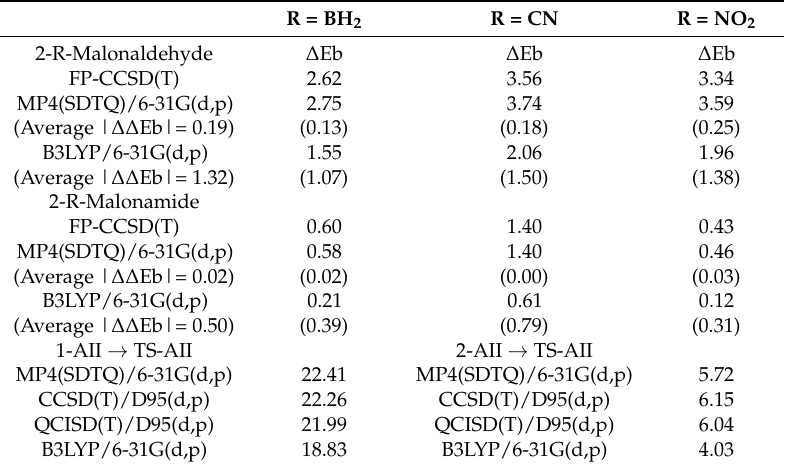
Table 2. Performance of MP4(SDTQ)/6-31G(d,p)//B3LYP/6-31G(d,p) in estimating the proton transfer barrier of six malonaldehyde derivatives. | ∆∆ Eb| refers to the absolute deviation of the calculated value from the FP-CCSD(T) reference